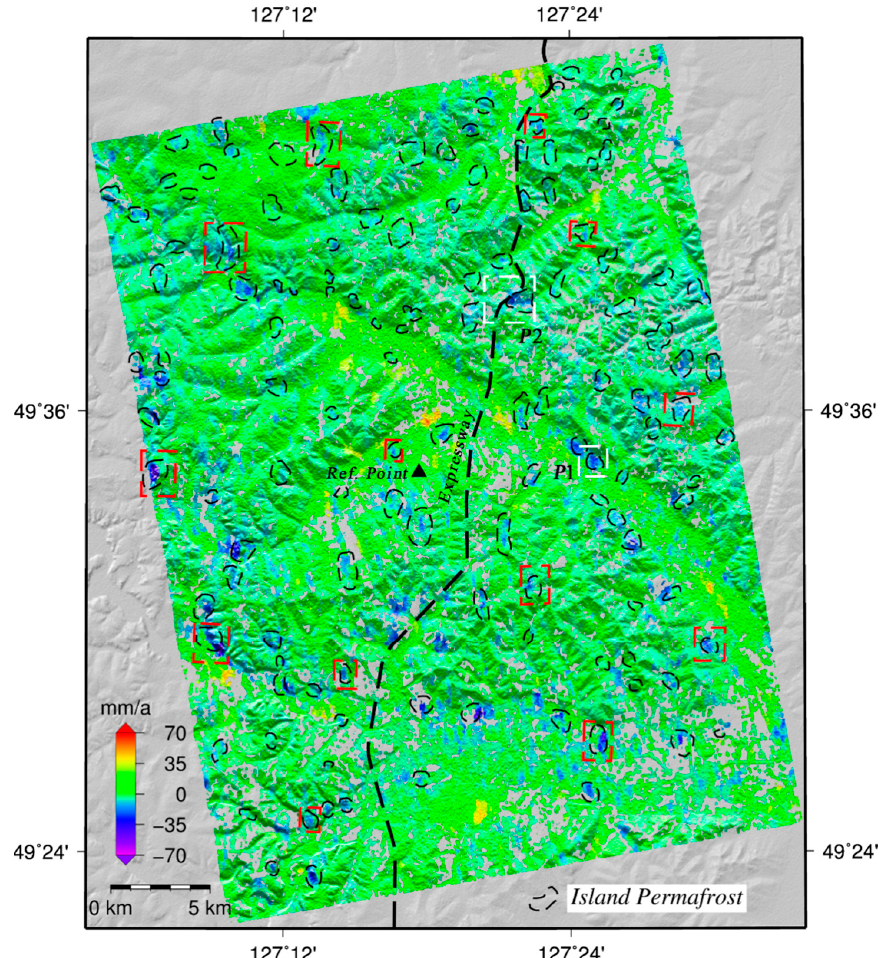
Figure 5. Average annual deformation rate along the line of sight direction. The background is DEM shaded relief, and the black dashed polygons denote the island permafrost areas, which were derived from Landsat images in our previous work [28]. The black triangle denotes the reference point, the bold black dashed line denotes the expressway from Bei’an to Heihe, and the white and red rectangles denote selected areas for further analysis in this study.